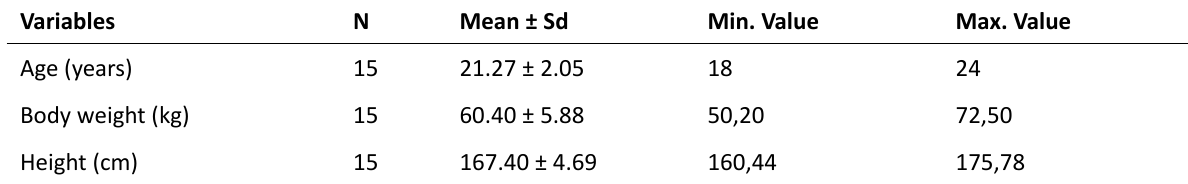
Table 1. Descriptive characteristics of the participants